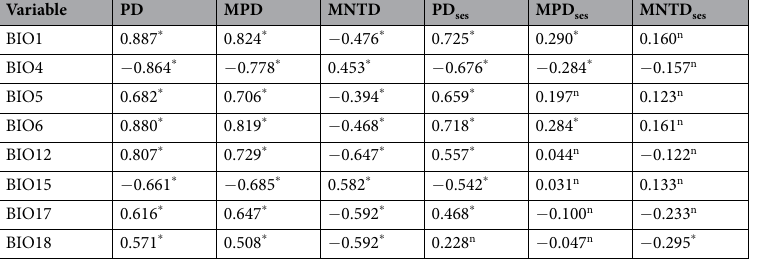
Table 1. Pearson’s correlation coefficients between phylogenetic metrics and environmental variables. Statistic significance: * P < 0.05, n P > = 0.05.